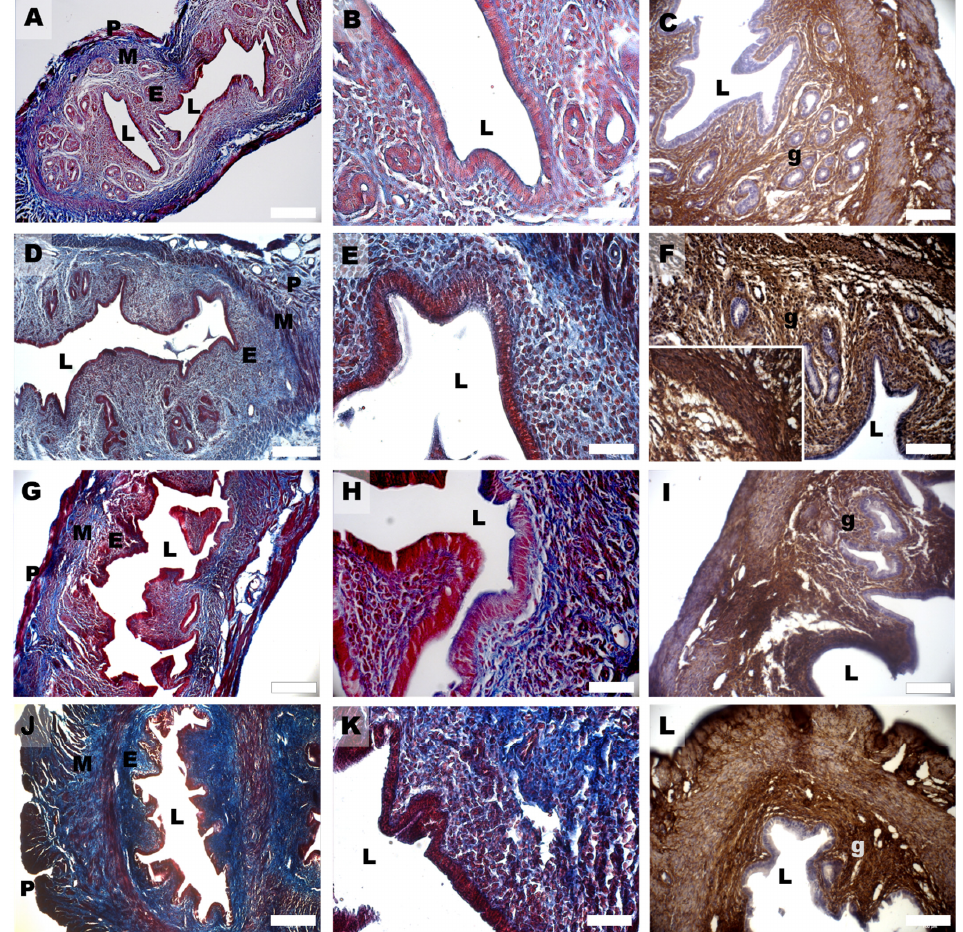
Figure 4. Mallory Trichrome ( A , B , D , E , G , H , J , K ) and Col1 ( C , F , I , L ) staining of mouse uterine horns of control ( A – C ), DHEA ( D – F ), DHEA/LC ‐ ALC ( G – I ) and DHEA/LC ‐ ALC ‐ PLC ( J – L ) groups. ( A , D , G , J ) low ‐ magnification LM pictures of the lumen (L), endometrium (E), myometrium (M) and perimetrium (P). ( B , E , H , K ) high magnification of the luminal epithelium. ( C , F , I , L ) glandular epithelium. Inset in F shows a detail of the tunica muscularis. LM, mag. 10x (( A , D , G , J ) Bar: 200 μ m), 20x (( B , C , E , F , H , I , K , L ) Bar: 100 μ m).